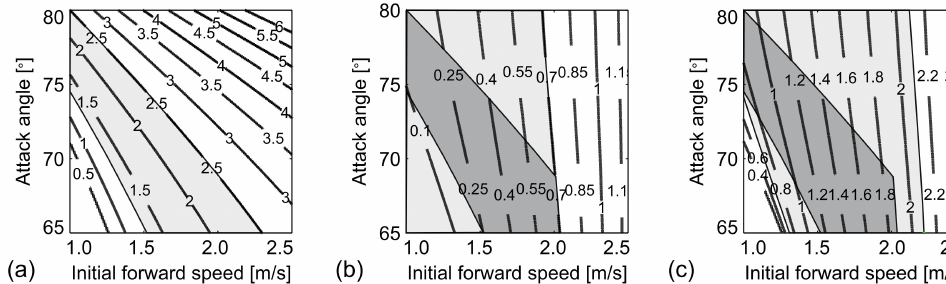
Figure 8. ( a ) Pacing rate, ( b ) DLF 1 , and ( c ) average forward speed of a pedestrian resulting from different combinations of the initial conditions in the IPM ( m p = 77.5 kg, l = 1.037 m). Refer to the text for explanation of the colours.